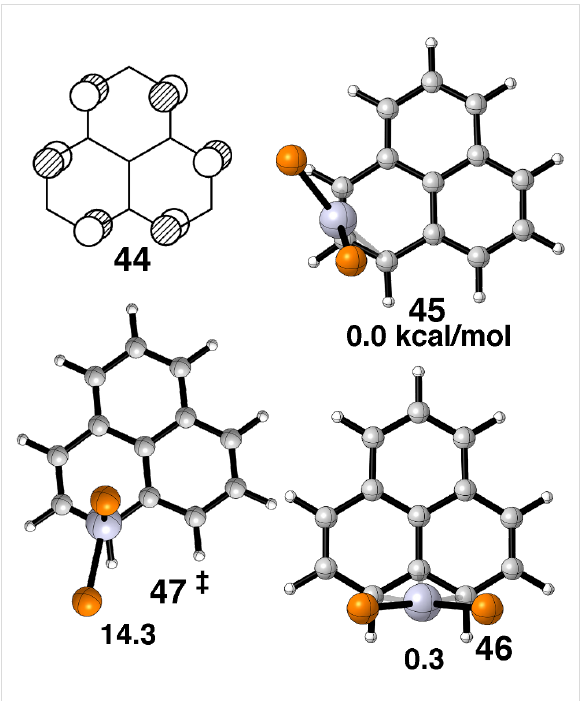
Figure 13: The LUMO of the phenalenium cation is given in 44 . The structures of the three stationary points found for phenaleni- um–Pt(dpe) + along with their relative energies are shown from a top view in 45 – 47 . Again the groups connected to the phosphorus atoms are not